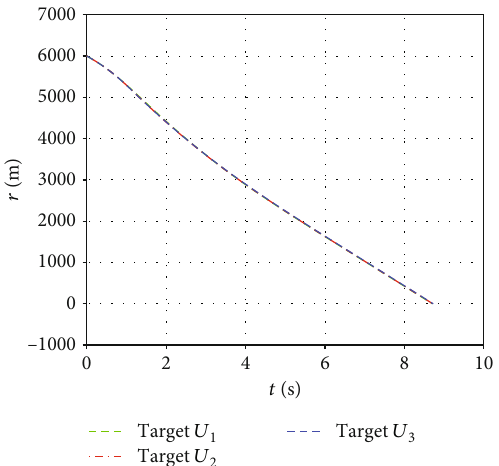
Figure 29: Target acceleration estimation in the pitch plane.